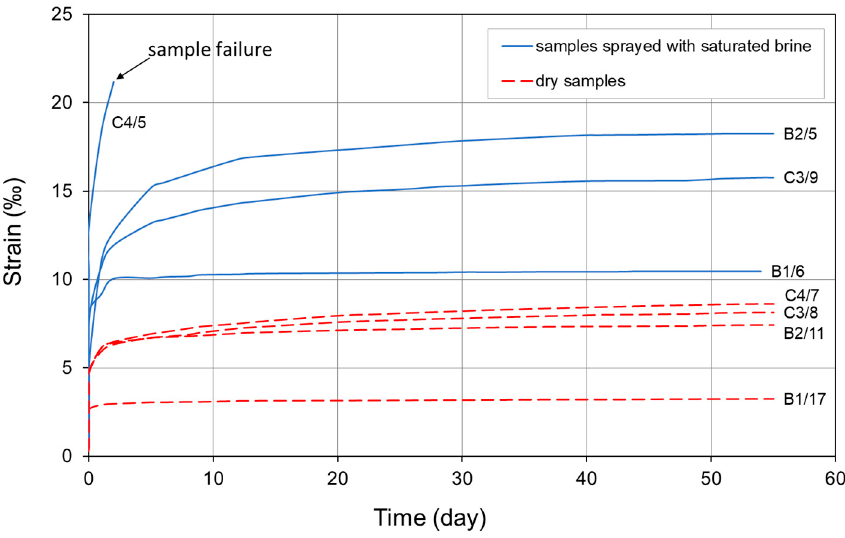
Figure 19. Creep curves of dry and saturated brine-sprayed samples ( σ 1 = 8 MPa).